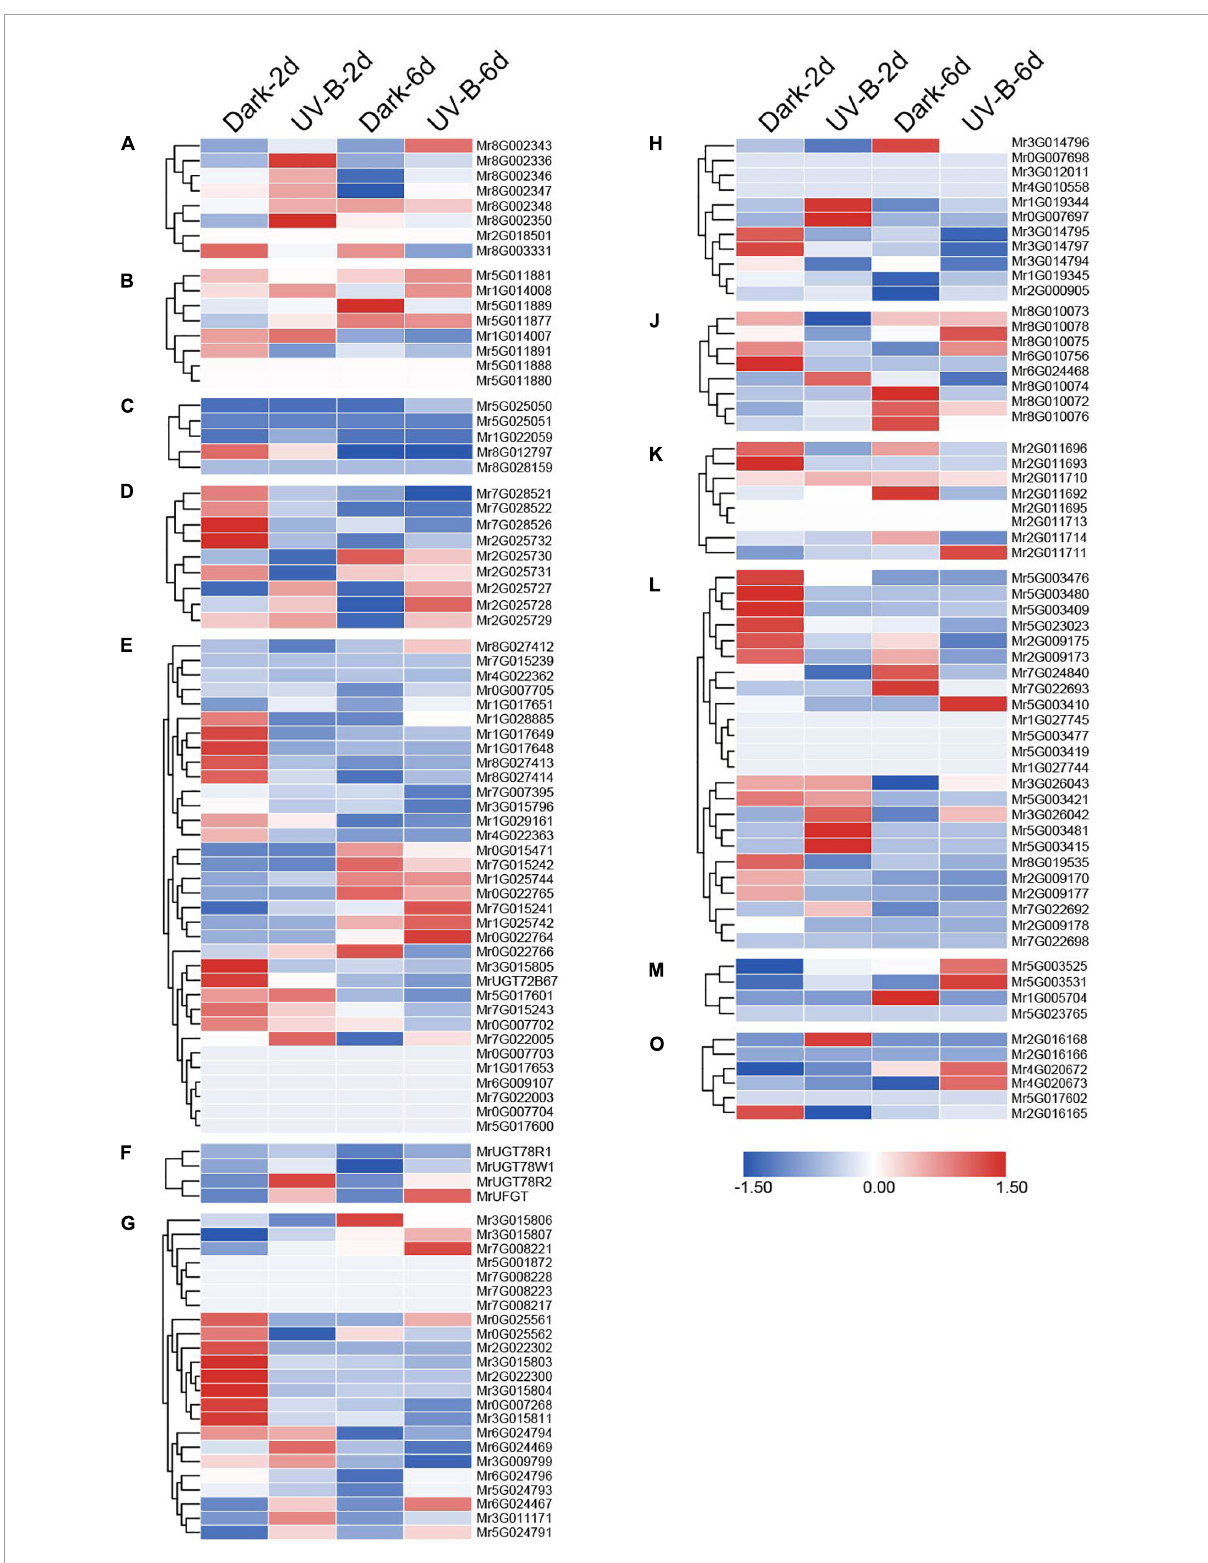
FIGURE5 Expression pattern of MrUGT genes in response to UV-B irradiation. Color scale represents –1.5 to 1.5. (A–H) , (J–M) , and (O) mean different phylogenetic groups of MrUGT